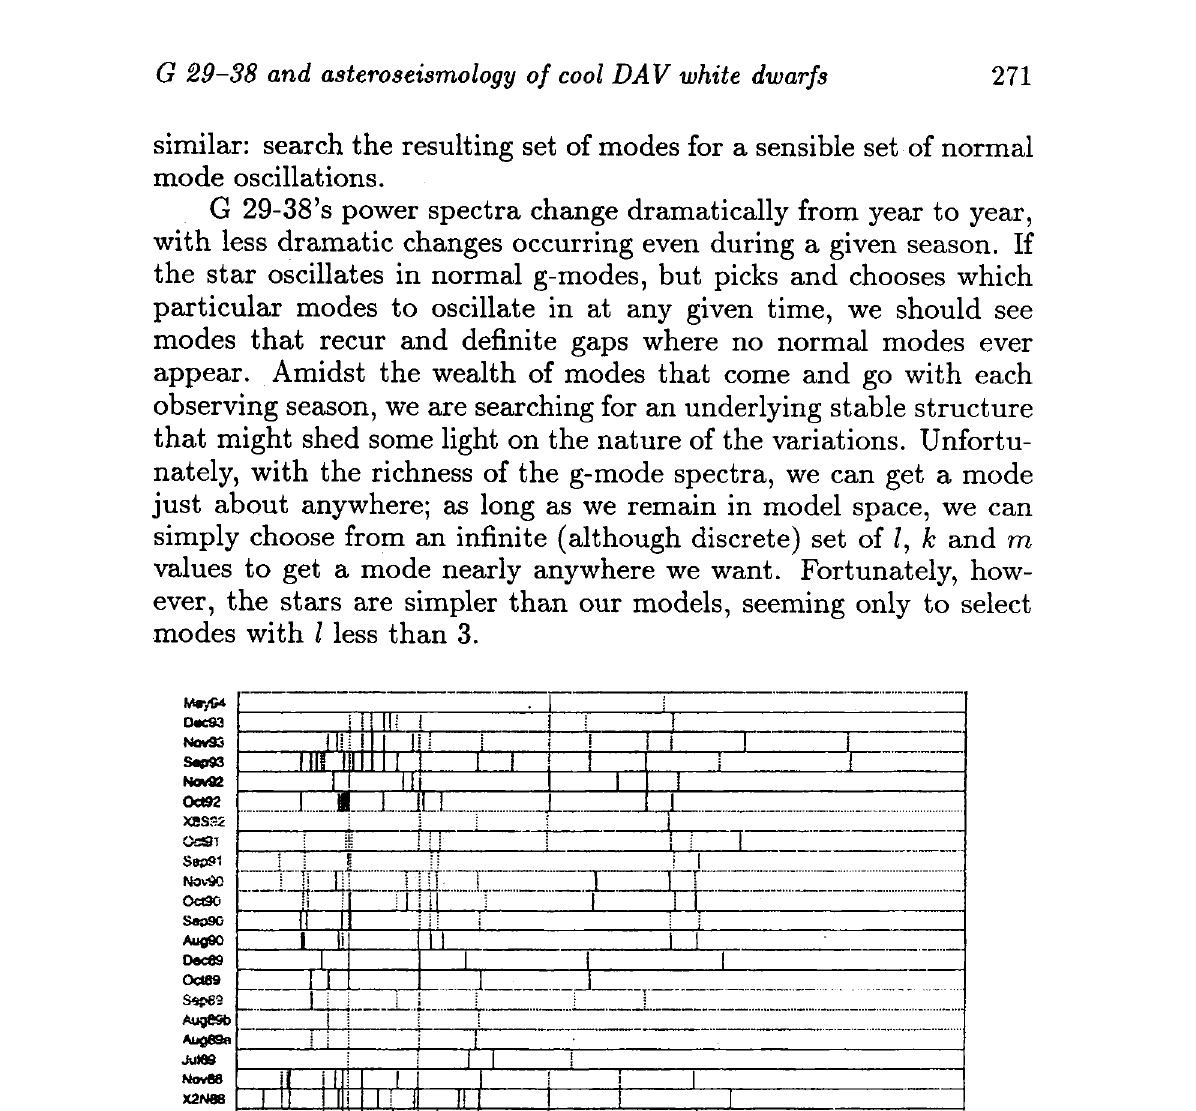
Fig. 1. Schematic diagram of G 29-38's periodicities for the entire data